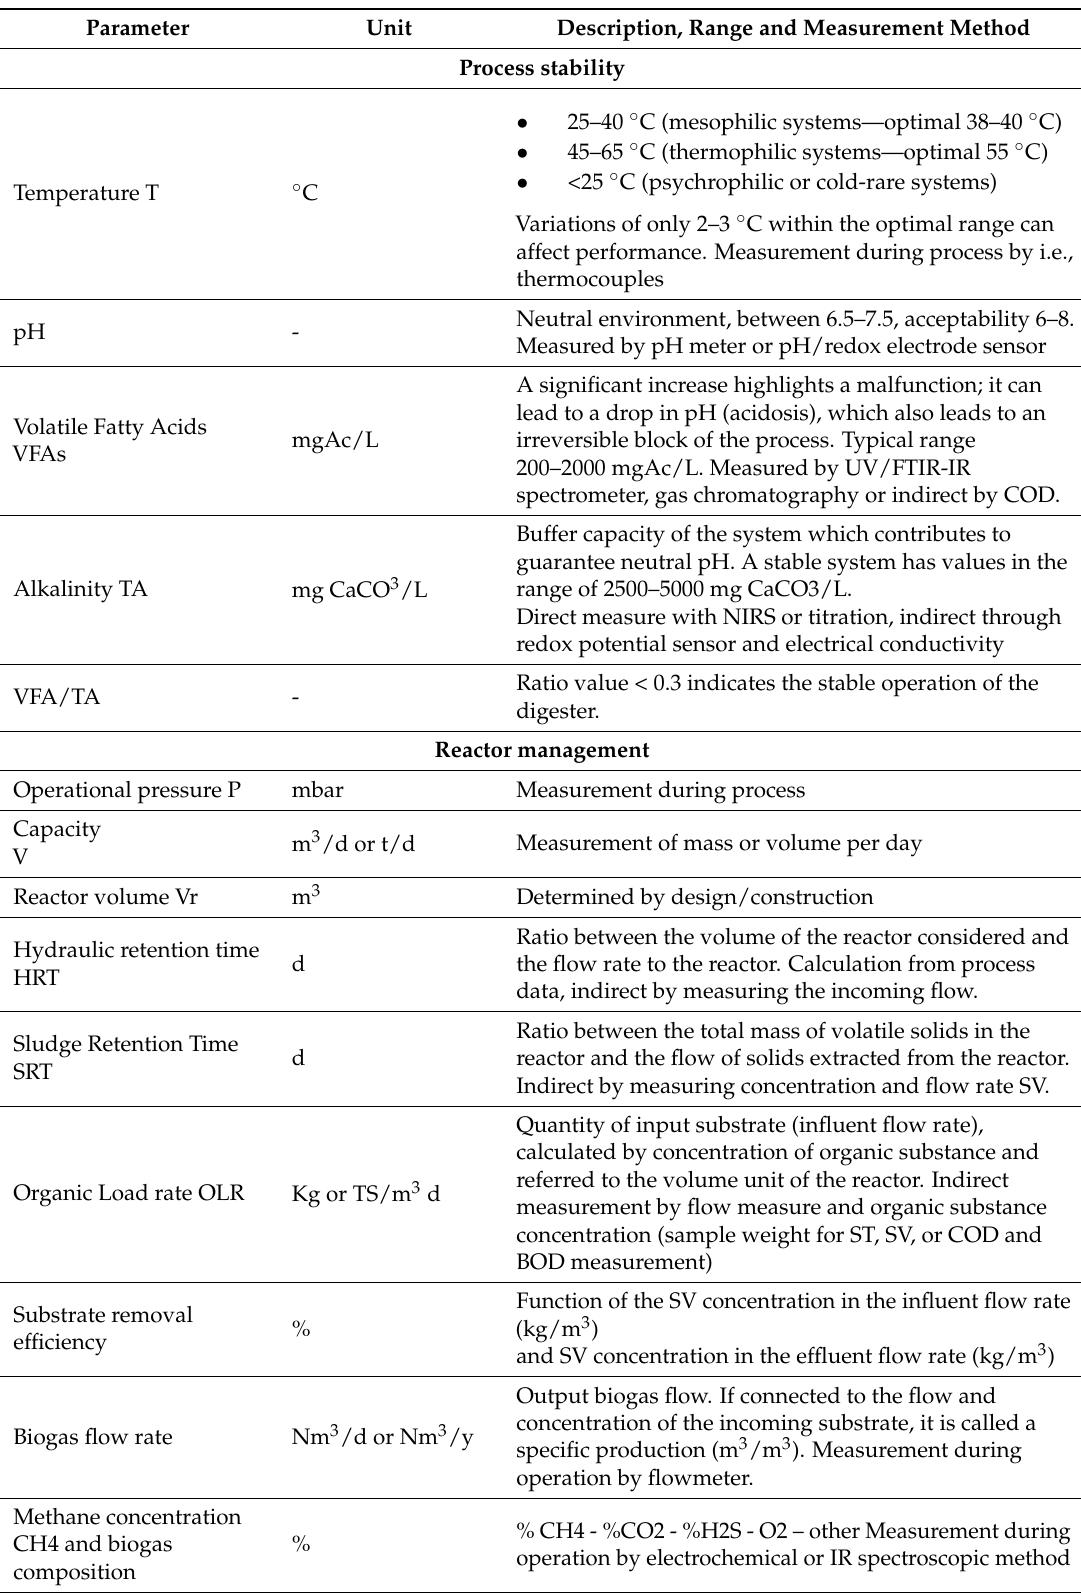
Table 3. Main parameters used to check the efficiency of anaerobic digestion plants